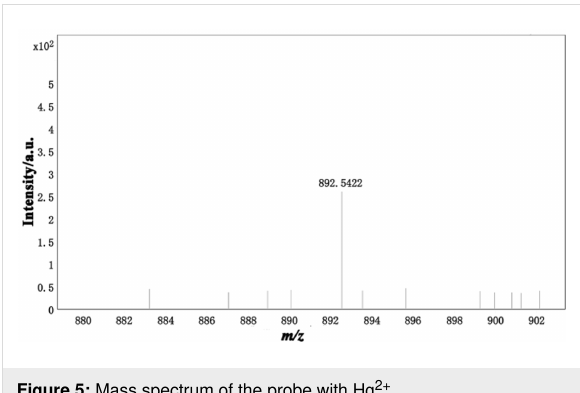
Figure 5: Mass spectrum of the probe with Hg 2+